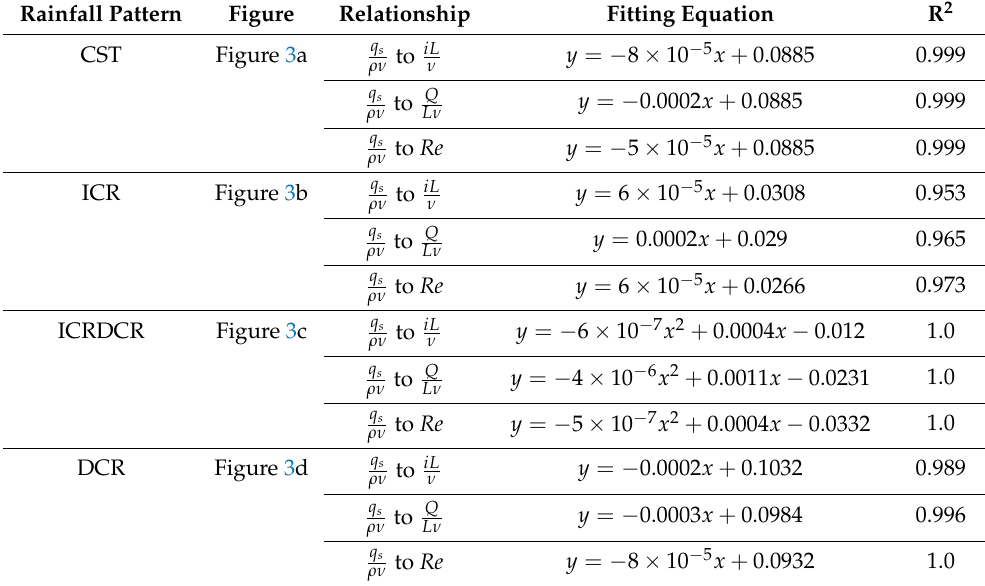
Table 7. Correlation coefficients relationship of dependent to each independent parameter based on different rainfall patterns (refer to Figure 3).